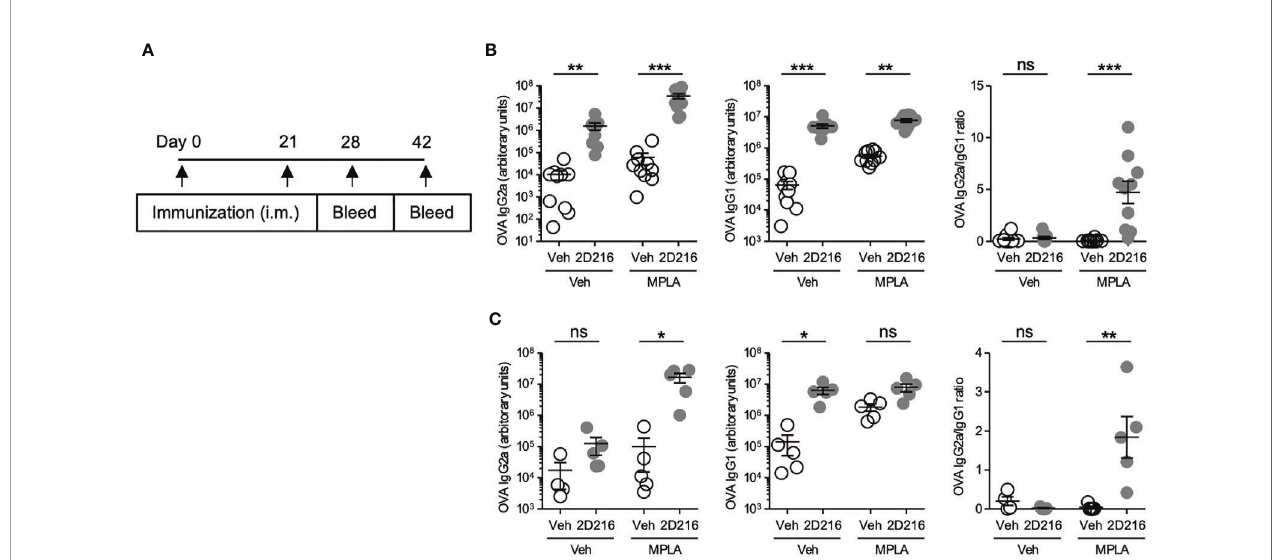
FIGURE 3 | 2D216 enhances MPLA-induced Th1-dominant adaptive immune responses in female mice. (A) Female BALB/c mice (n = 5-10/group) were i.m. immunized with OVA (20 m g/mouse) adjuvanted with vehicle (Veh; 10%DMSO in saline), 2D216 (200 nmol/mouse), MPLA (10 ng/mouse), or a combination (MPLA/ 2D216) and bled on day 28 and day 42. OVA-speci fi c IgG2a and IgG1 levels in sera from day 28 (B) and day 42 (C) were assayed by ELISA. IgG2a/IgG1 ratio was calculated. Data shown are means ± SEM of two independent experiments showing similar results. *p < 0.05, **p < 0.01, ***p < 0.001 by Kruskal-Wallis tests with Dunn ’ s post hoc test. ns, not signi fi